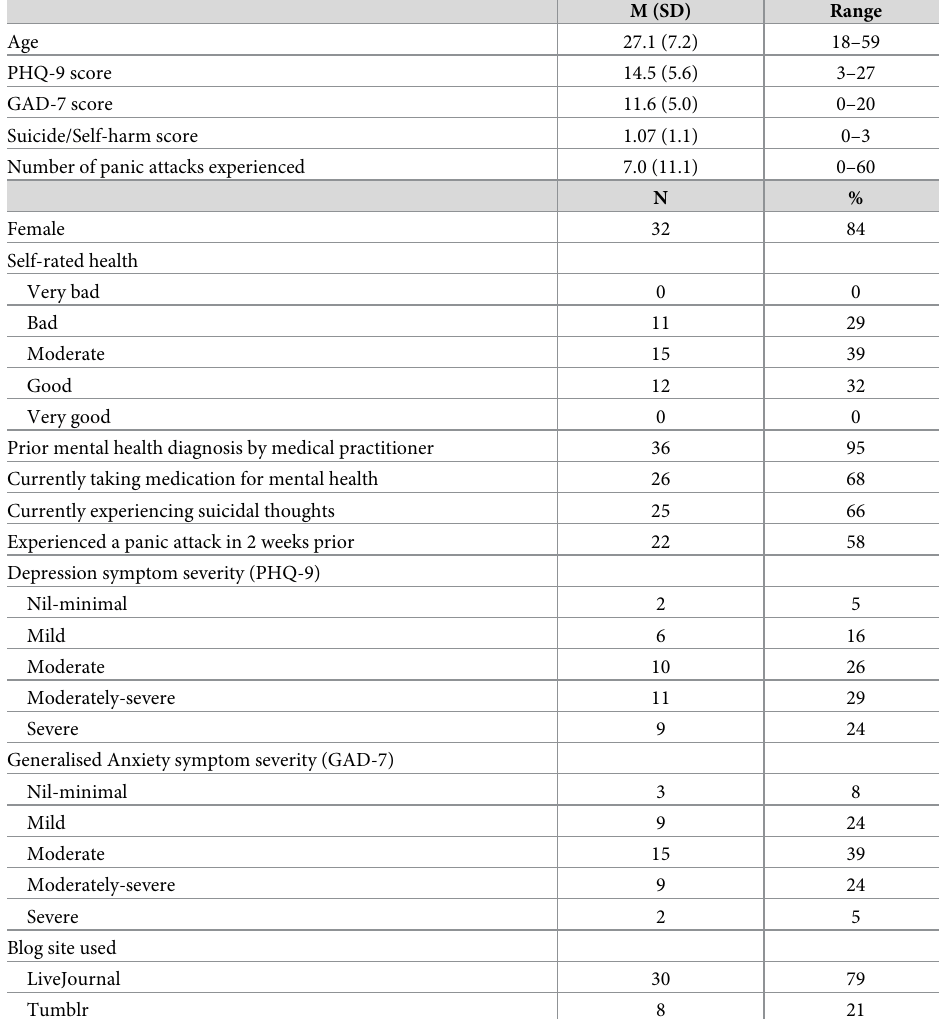
Table 1. Participant characteristics at baseline (N =